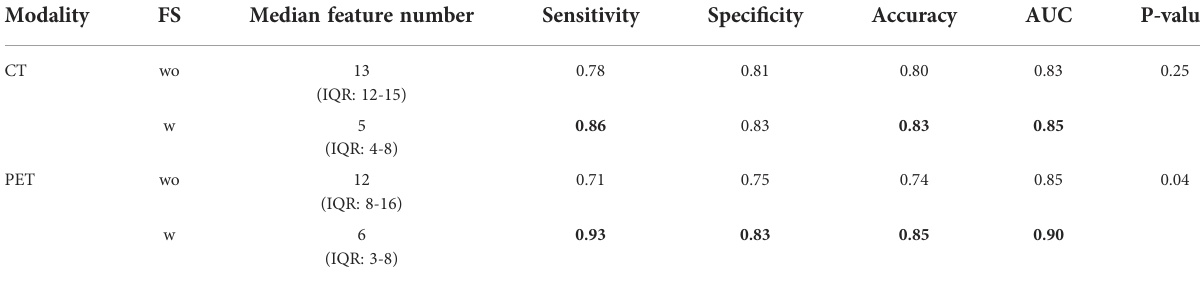
The bold values indicate the best results of the related metrics for CT and PET radiomics models separately.